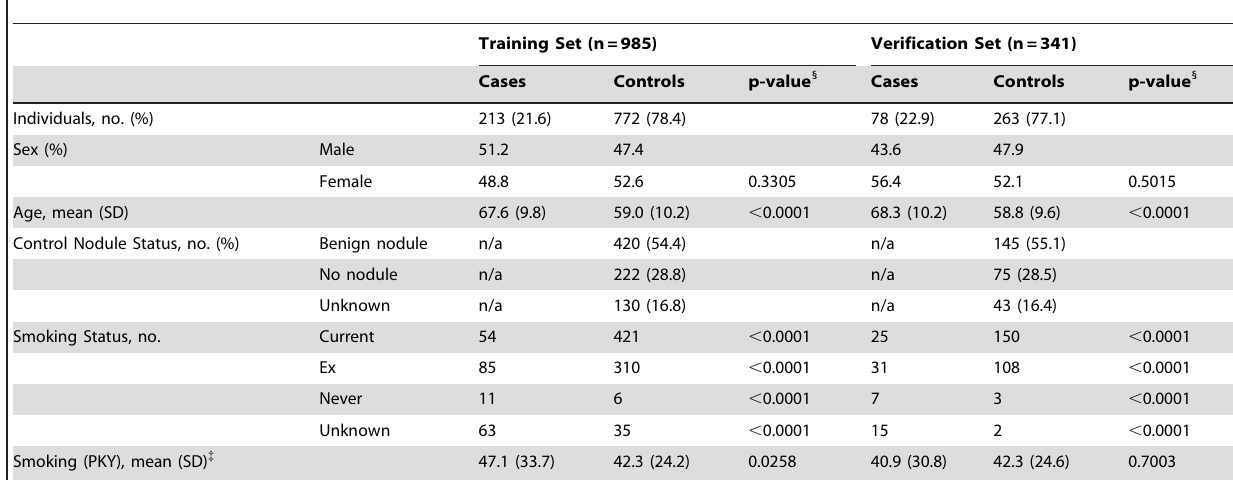
Table 2. Clinical characteristics of NSCLC case and control sets for training and verification.